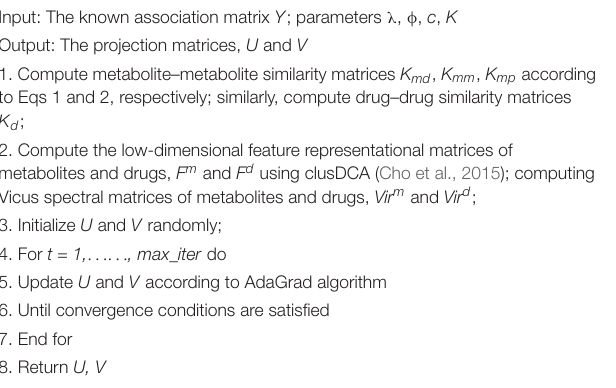
TABLE 2 | The best performance of all methods on the “DrugMetaboliteAtlas” dataset. AUC AUPR F1